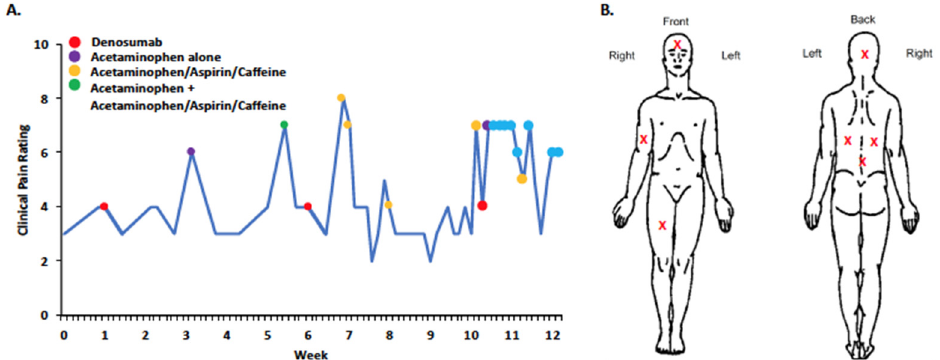
Figure 2. ( A ) The 12-week daily pain diary completed by Patient 1 while undergoing treatment with denosumab at age 23. Average pain was assessed using a 0–10 numerical rating scale and was initiated before the onset of denosumab treatment. ( B ) At baseline and using the BPI, anatomical regions where pain was experienced was identified on a body map. Pain was widespread and present in craniofacial and axial–appendicular